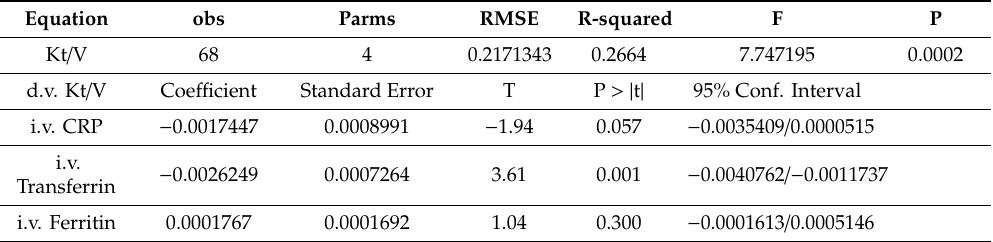
Table 7. Prediction of haemodialysis adequacy.